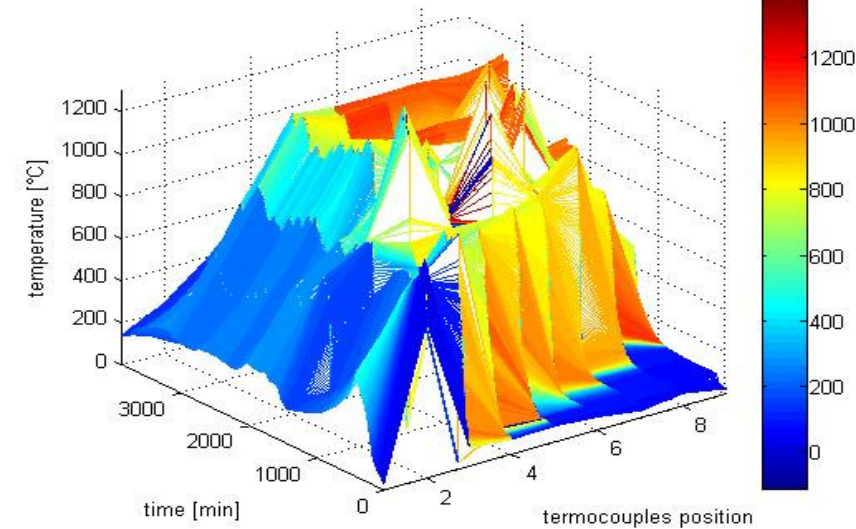
Figure 10. Time profile of the temperatures in the gasification channel along the length of the generator for the second experiment..